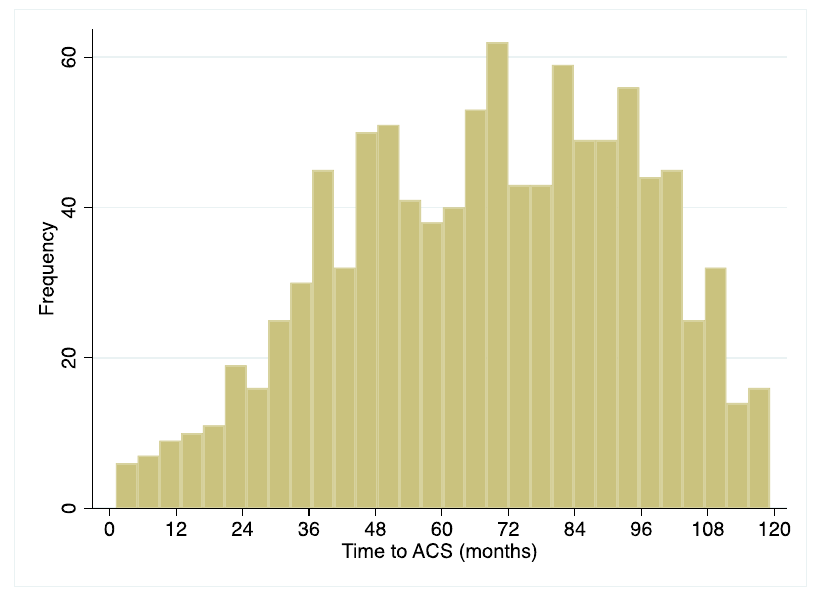
Figure 3. Time to the onset of the MI from renal transplant in 1020 patients with renal transplant and MI during follow-up. Mean 68 ± 27 months; median 70, IQR 48–90 months. (ACS = Acute coronary syndrome). Rates of all-cause mortality within 8-day and 30-day post-MI were lower in the RT patients